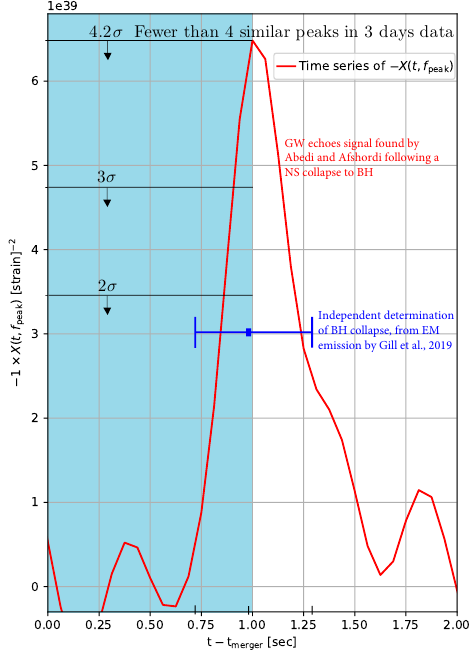
Figure 25. Amplitude-time plot of first echo peak at 1.0 sec after the merger at frequency of 72 Hz [20]. After this detection Gill et al. [149] with independent Astrophysical considerations also determined that the remnant of GW170817 must have collapsed to a BH after t coll = 0.98 + 0.31 (in blue) is the time of collapse considering this independent observation in [149] compared to the detected signal of echoes which is also as a consequence of BH collapse. The shaded region is 0–1 s prior range after the